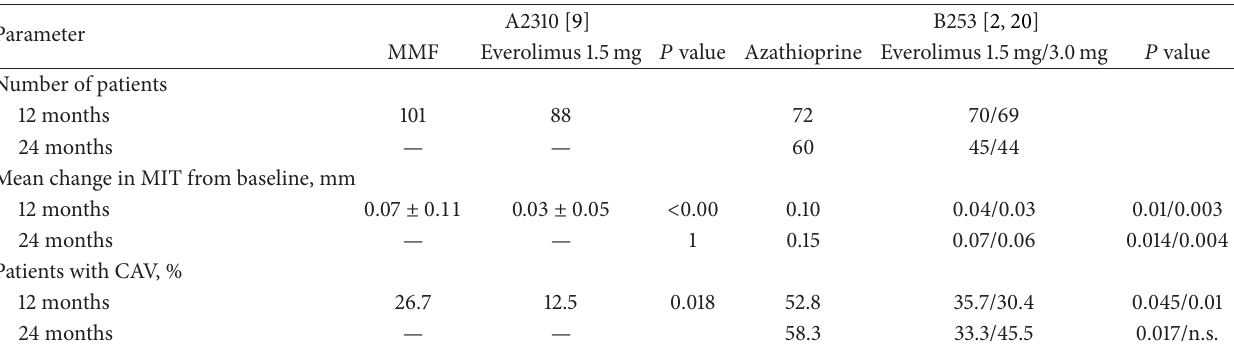
Table3:Resultsofintravascularultrasound(IVUS)substudiesinrandomizedtrialsofeverolimuswithreduced-exposurecyclosporineversus MMF with standard-exposure